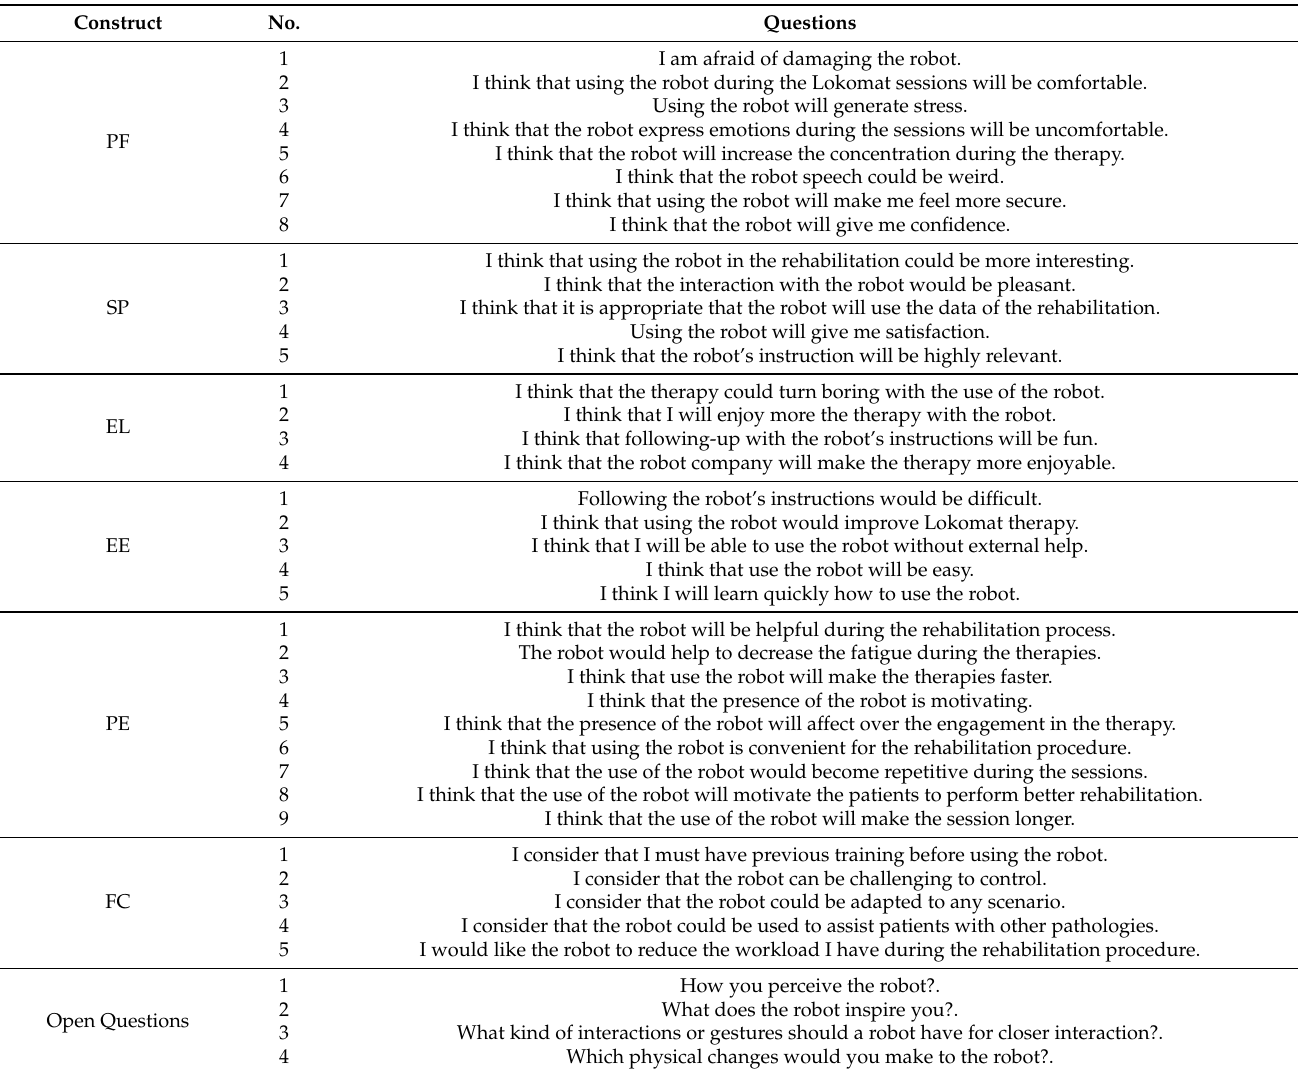
Table A1. Acceptance Questionnaire for Lokomat Therapy